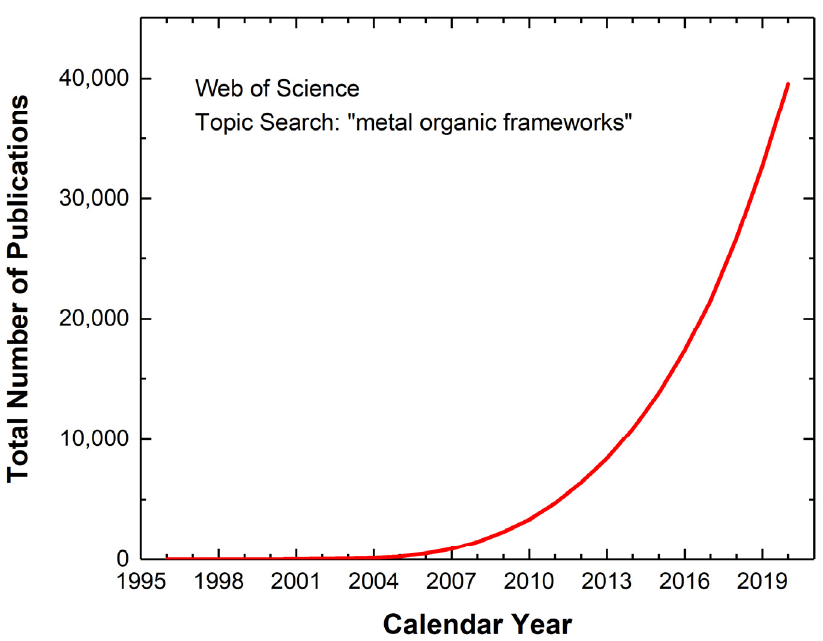
Figure 1. Total number of publications in scientific literature over the past 20+ years for “metal organic frameworks” as per Web of Science topic search engine.